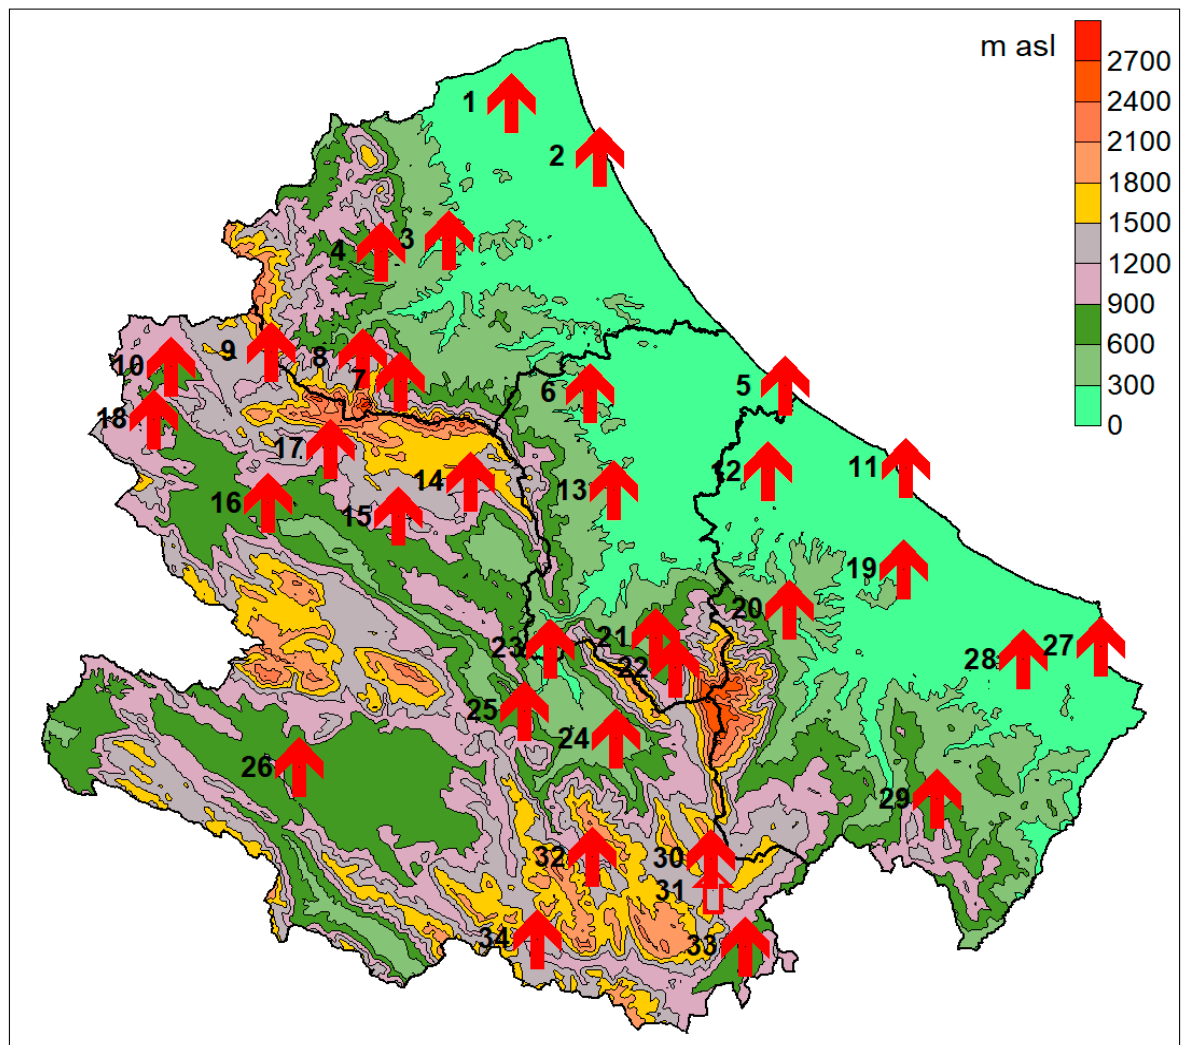
Figure 7. Analysis of GDD trends accumulated in the period April–October. The upward arrows denote increasing trends. Full arrows indicate significant trends with p < 0.05. The red arrows represent a warming trend. The number next to the arrow indicates the numeric code of the meteorological station. The altitude classes are given on the upper right.